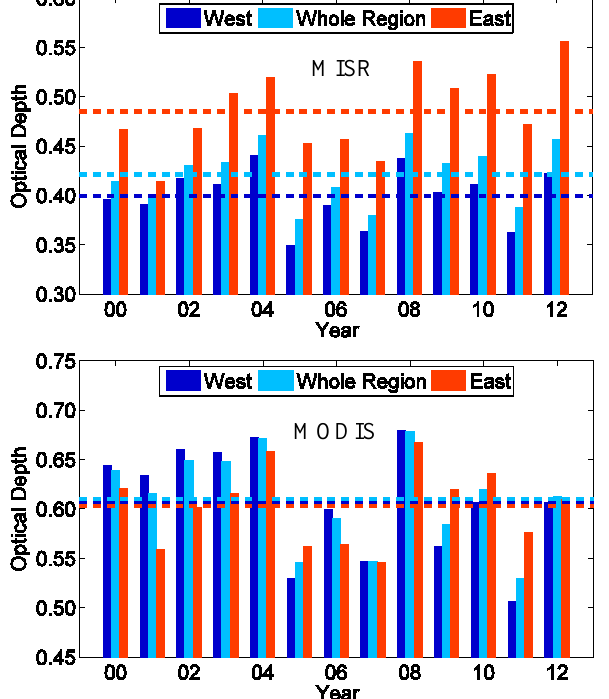
Figure 4. Time series of mean aerosol optical depth at 0.55nm in the Indo–Gangetic Basin averaged over the months of March–May as derived from MISR (top) and MODIS (bottom). Values are given also for eastern and western portions of the IGB, separated at 82 ◦ E. Dashed lines: mean AOD for the region averaged over the months of March–May for the period 2000–2012 for the entire domain and eastern and western portions. Notice the difference in scales on the y